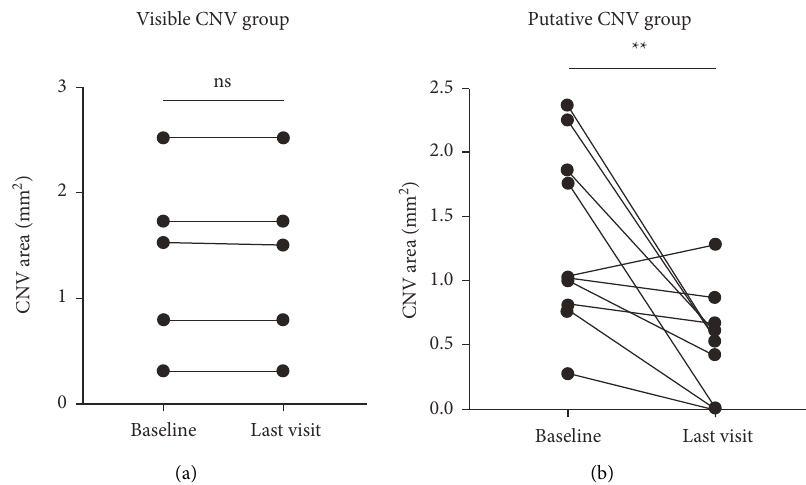
Figure 5: The changes of visible or putative CNV area at baseline and at the final follow-up after anti-VEGF treatment. (a) The changes of CNV area in the visible CNV group. (b) The changes of putative CNV area in the putative CNV group. The data were represented as mean ± SD; CNV, choroidal neovascularization. The statistics was analyzed by paired t-test, ns, not statistically significant; ∗∗ P < 0 .